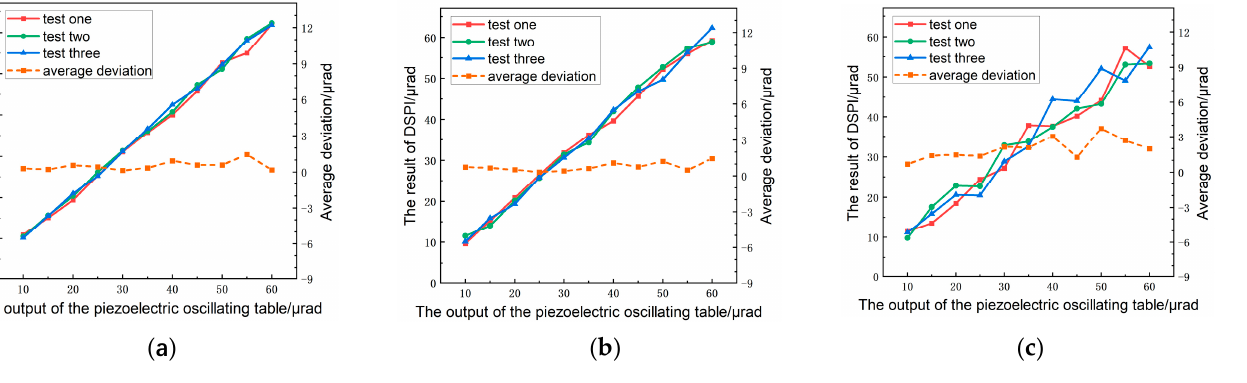
Figure 5. Simultaneous measurement results: ( a ) the measurement values of pitch, ( b ) the measurement values of yaw, ( c ) the measurement values of roll.